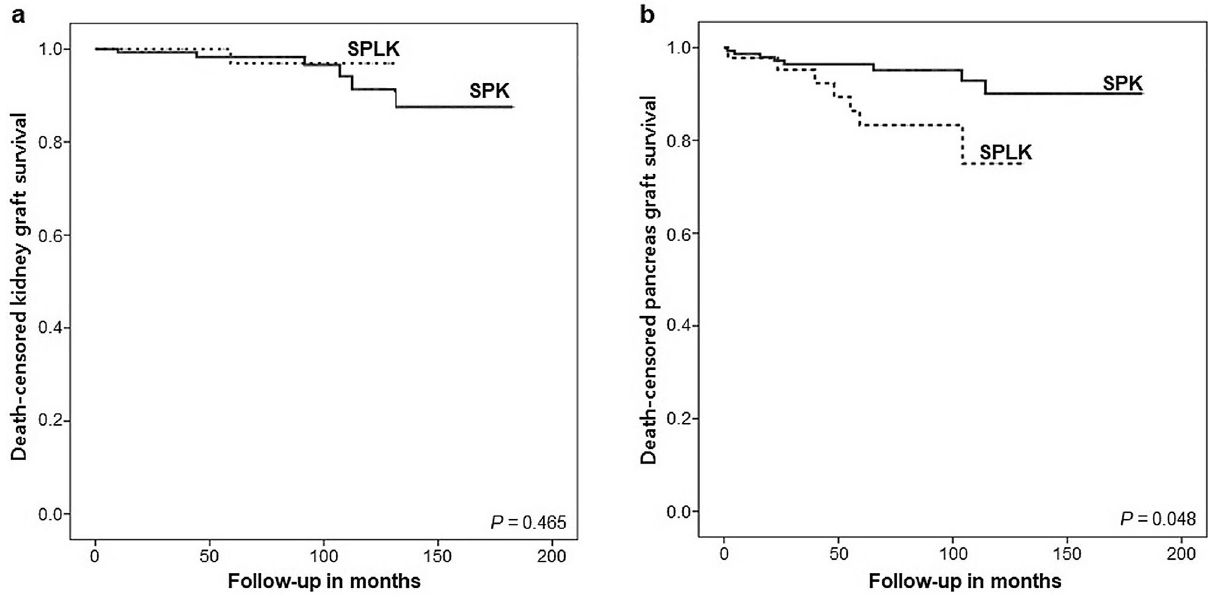
Figure 3. Rates of ( a ) death-censored kidney graft survival and ( b ) death-censored pancreas graft survival in the simultaneous pancreas-kidney (SPK) transplant group and the pancreas and living-kidney transplantation (SPLK) transplant